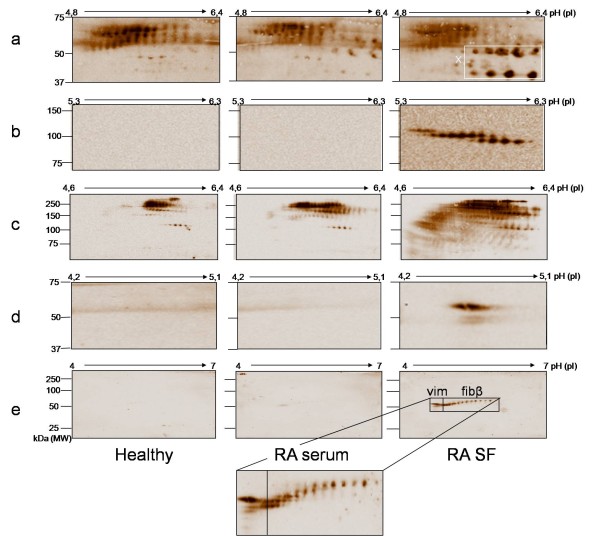
Identification of antigens in IC of healthy serum, RA serum and RA SF by immunodetection. 100 μg IC purified from healthy serum, RA serum and RA SF were analysed on Western blot (pH 4 to 7) and immunodetection was performed with anti-fibrinogenβ (a), anti-fibrinogenγ (b), anti-fibronectin (c), anti-vimentin (d) and AMC staining (e). Note that different mass and pI scales were used for clarity. Box × indicates processed isoforms of Fibβ.